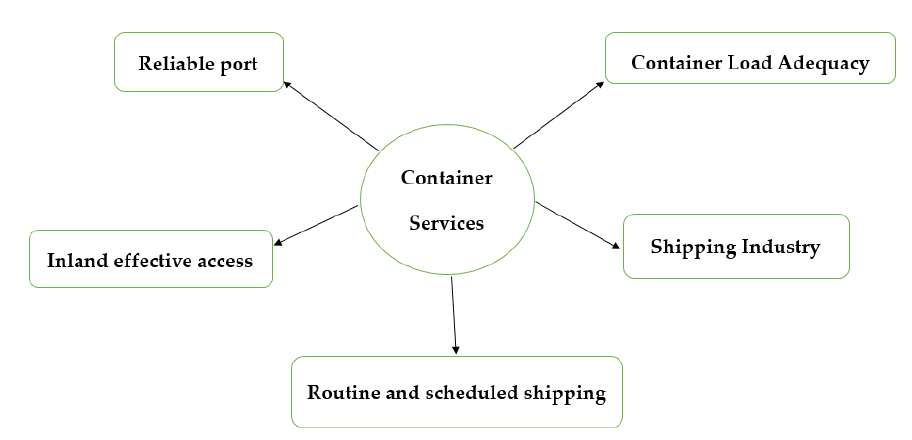
Figure 2. Chart of sea toll elements container services. Source: Indonesian Main Sea-Corridor [13].